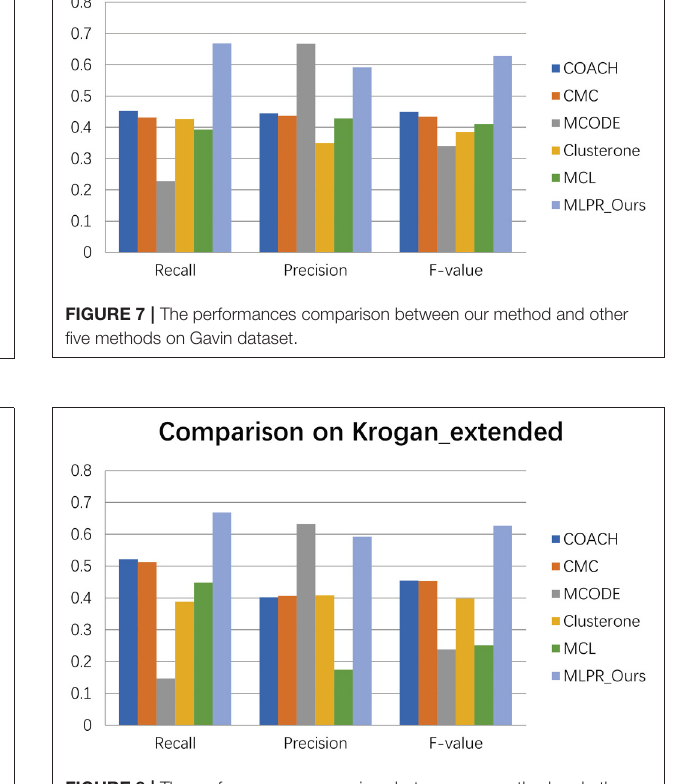
FIGURE 8 | The performances comparison between our method and other five methods on Krogan extended